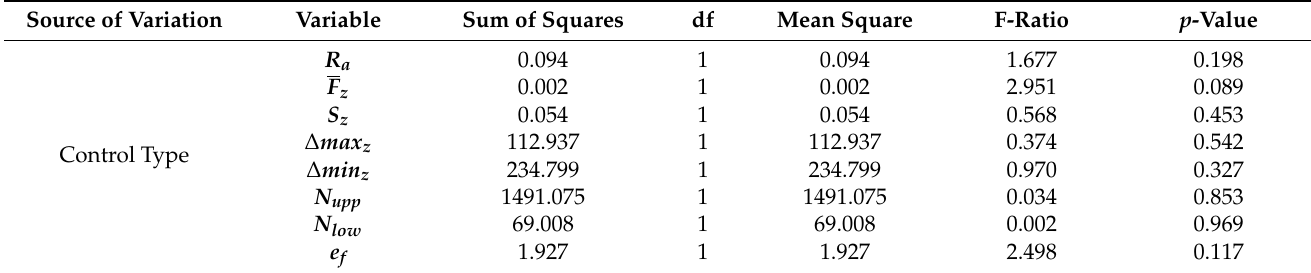
Table 3. ANOVA results (part one).